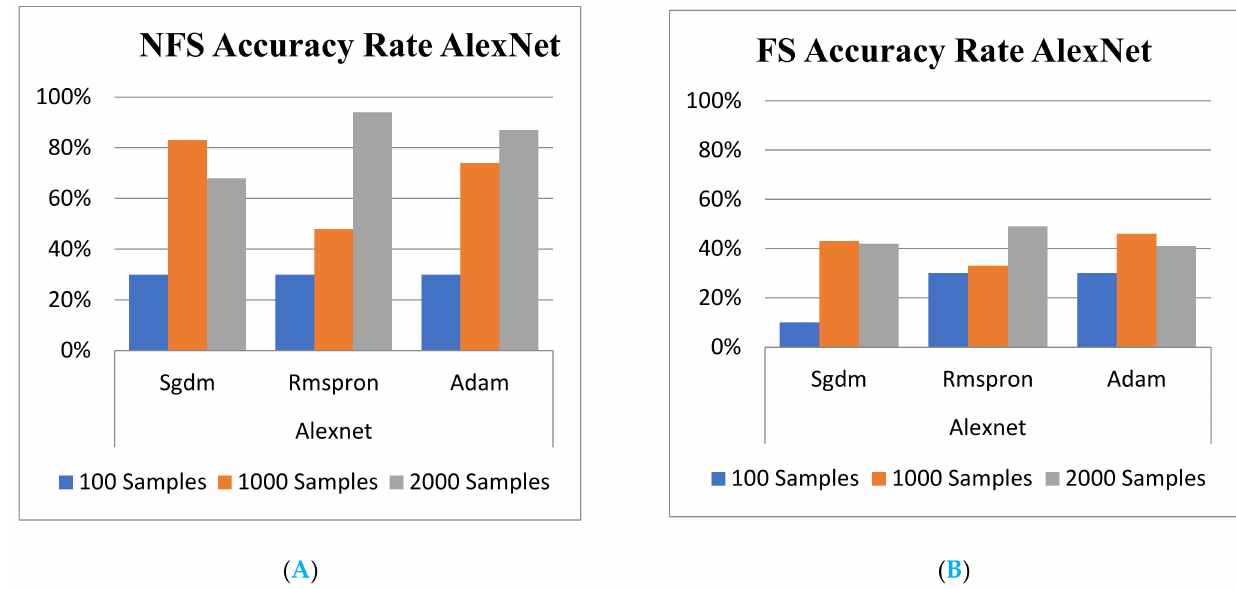
Figure 8. Training Accuracy rate for GoogLeNet. ( A ) with FS; ( B ) without FS.